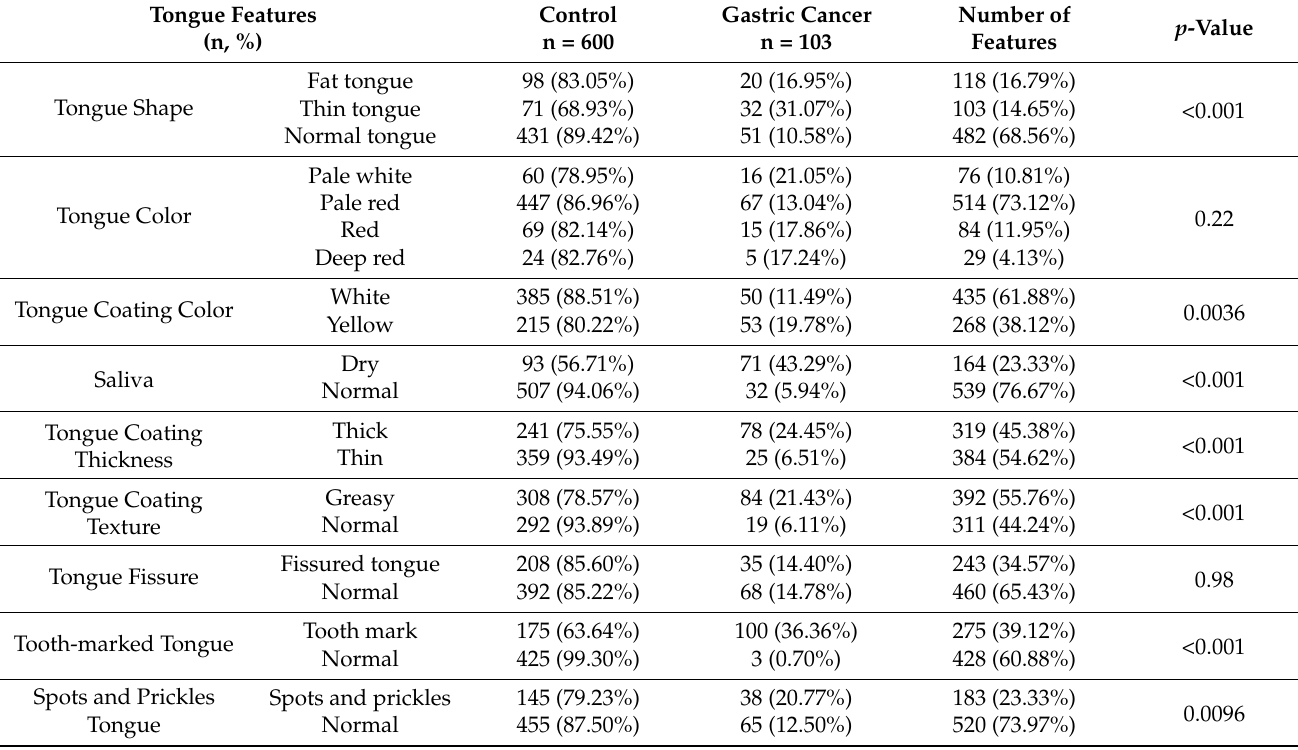
Table 1. Comparison of tongue features between patients with gastric cancer and control